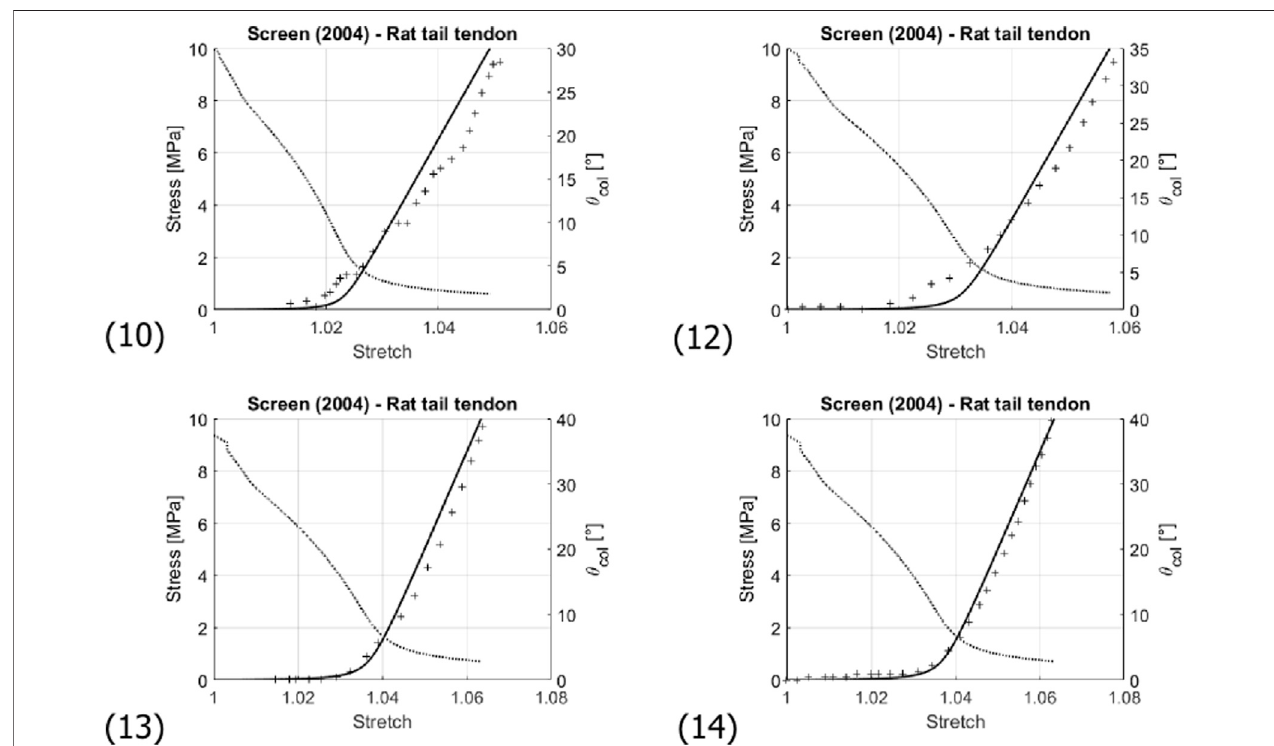
FIGURE8| Comparisonoftheexperimentally-measured(crosses) andpredicted (solidline)stress-stretchcurveoffasciclesofrattailtendons;andevolutionofthe collagen fi brilinclination angle θ col (dashedline). Numbering ofthe sub fi gures refers to Table 3 . Note that stressand angle values arelabelled at the leftand right sidesof the diagrams,